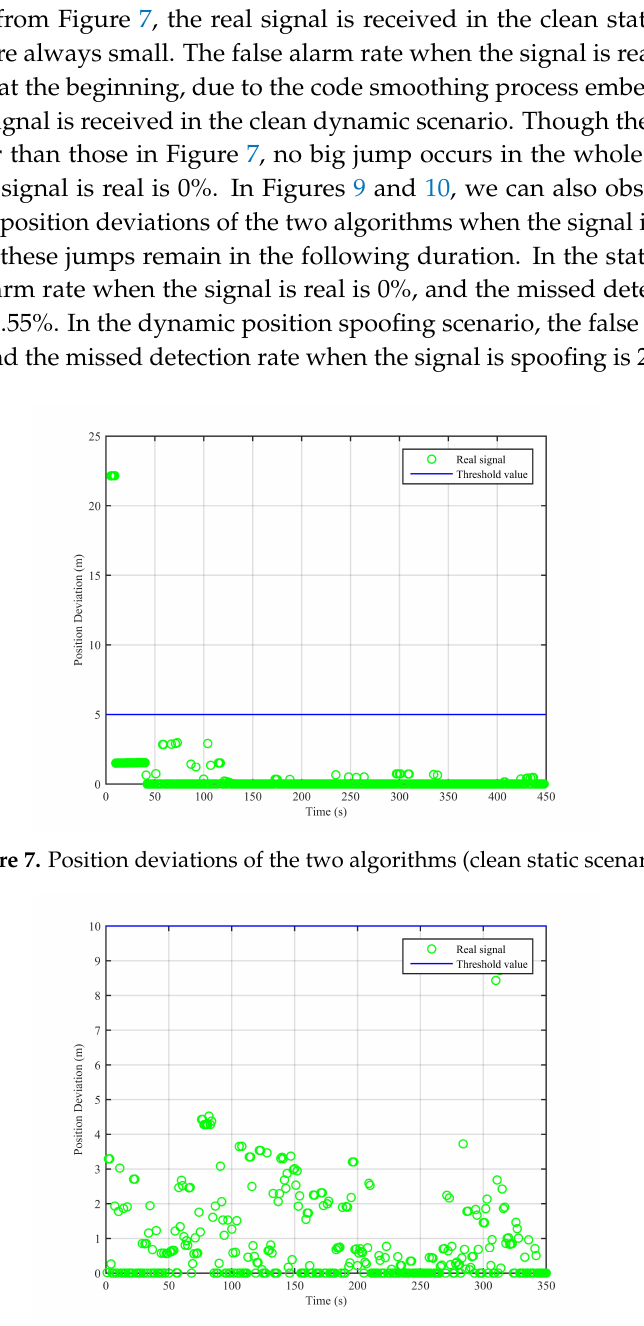
Figure 8. Position deviations of the two algorithms (clean dynamic